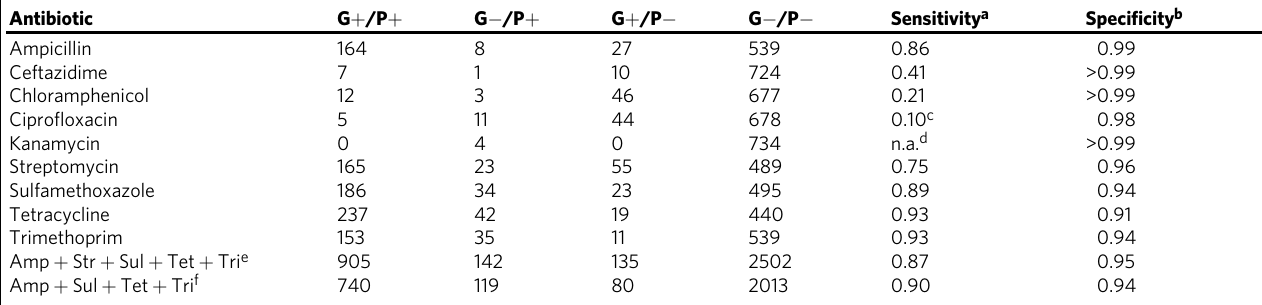
Table 1 Presence and absence data.